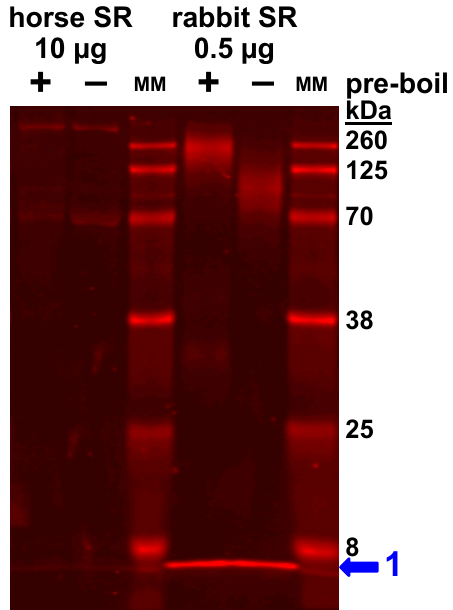
Figure 3. Immunoblot analysis using commercial anti-rabbit / mouse / human-SLN pAb ABT13 identifies SLN protein expression in rabbit SR vesicles, but not in horse SR. The primary antibody was the commercial anti-SLN pAb ABT13, with immunogen comprising rabbit / mouse / human SLN residues 27 RSYQY 31 , whereas horse SLN encodes 26 RSYQ 29 . Samples were electrophoresed through a 10% Laemmli gel. Horse SR vesicles were loaded at 10 µ g protein per lane (left), and rabbit SR vesicles were loaded at 0.5 µ g protein per lane (right). Immunoblotting was performed using pAb ABT13 (primary) and goat anti-rabbit-IgG pAb labeled with 680-nm fluorophore (secondary). Immunolabeling was quantified using the LI-COR laser scanner system. Prior to electrophoresis, one sample of each SR prep was heated at 100 °C for 2 min in Laemmli sample buffer (+ pre-boil). Protein gel markers (kDa) are indicated on the right. The putative monomeric form of SLN on SDS-PAGE is indicated by the blue arrow with number 1 on the right.